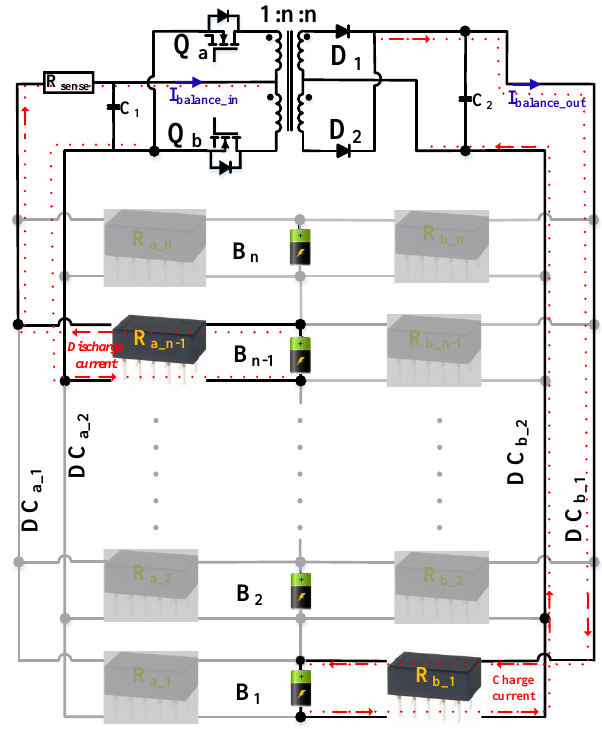
Figure 6. Structure of the proposed cell balancing circuit.